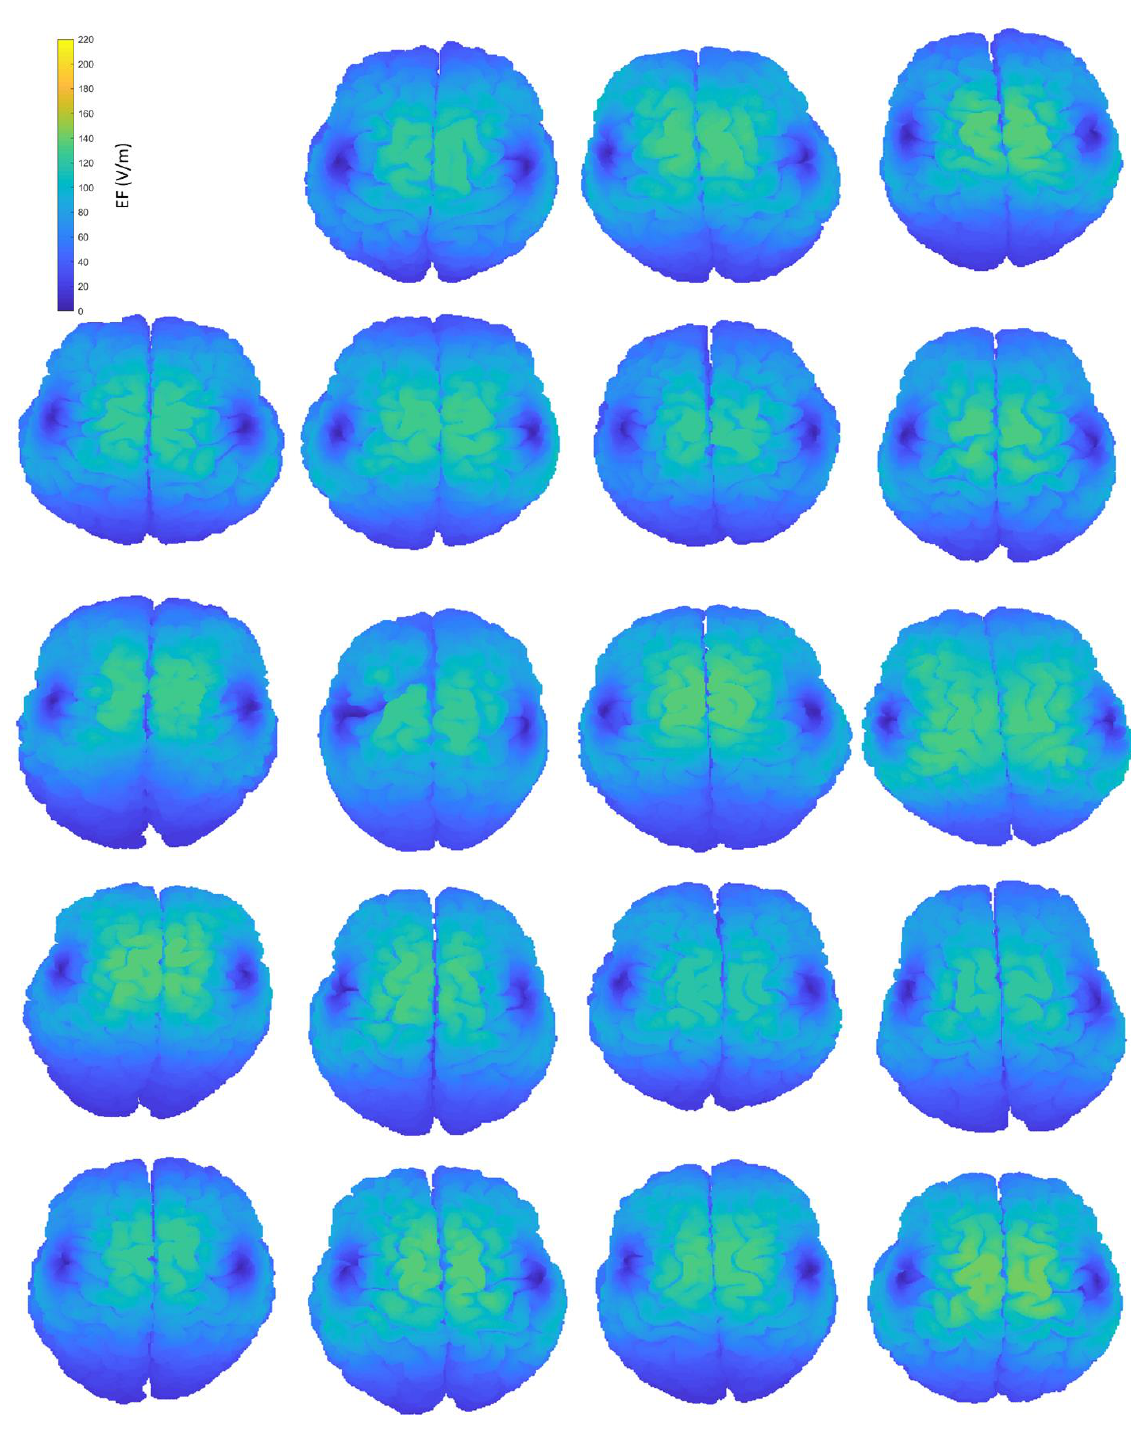
Figure A3. Interindividual variability of the induced EF distributions visualized on subjects’ homo- geneous brains, containing both grey and white matter, when the coil is placed at central position.